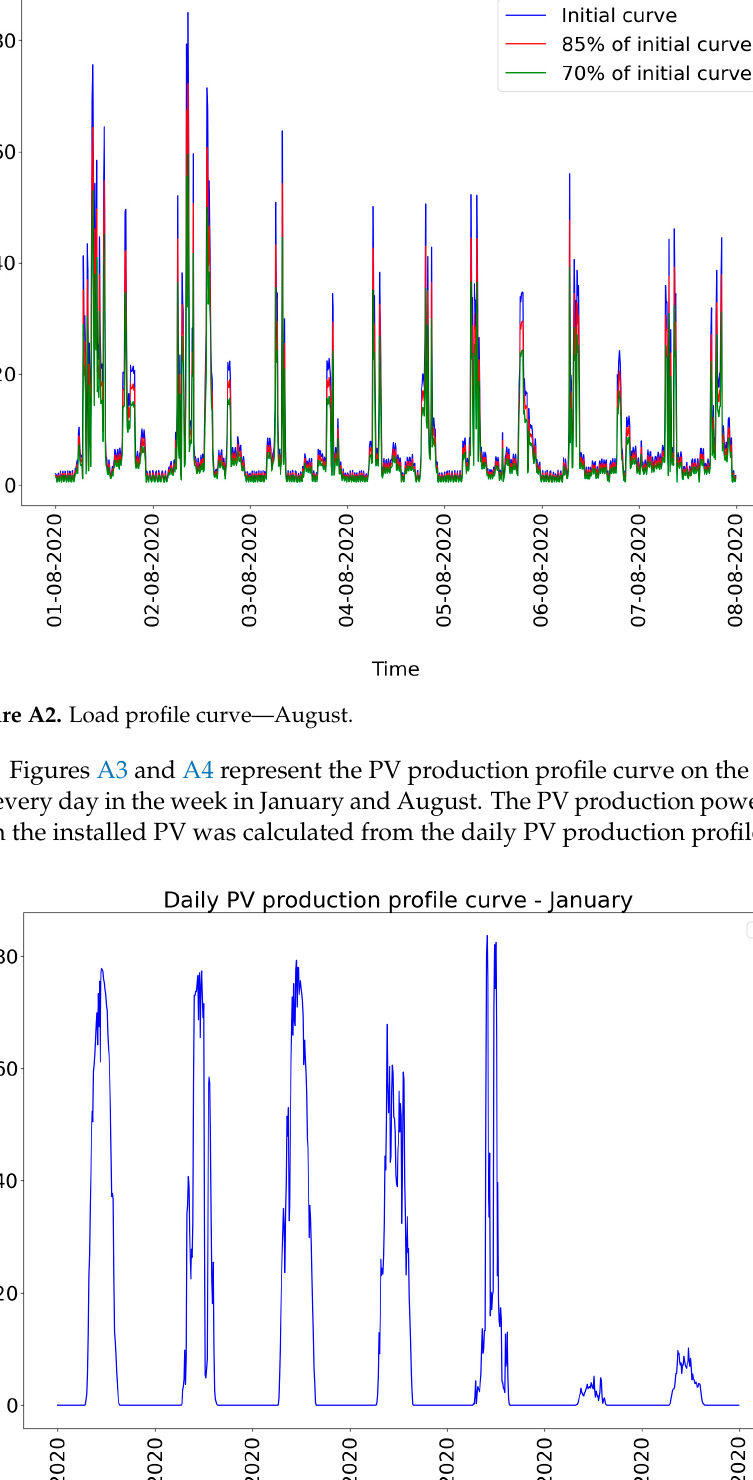
Figure A1. Load profile curve–January.